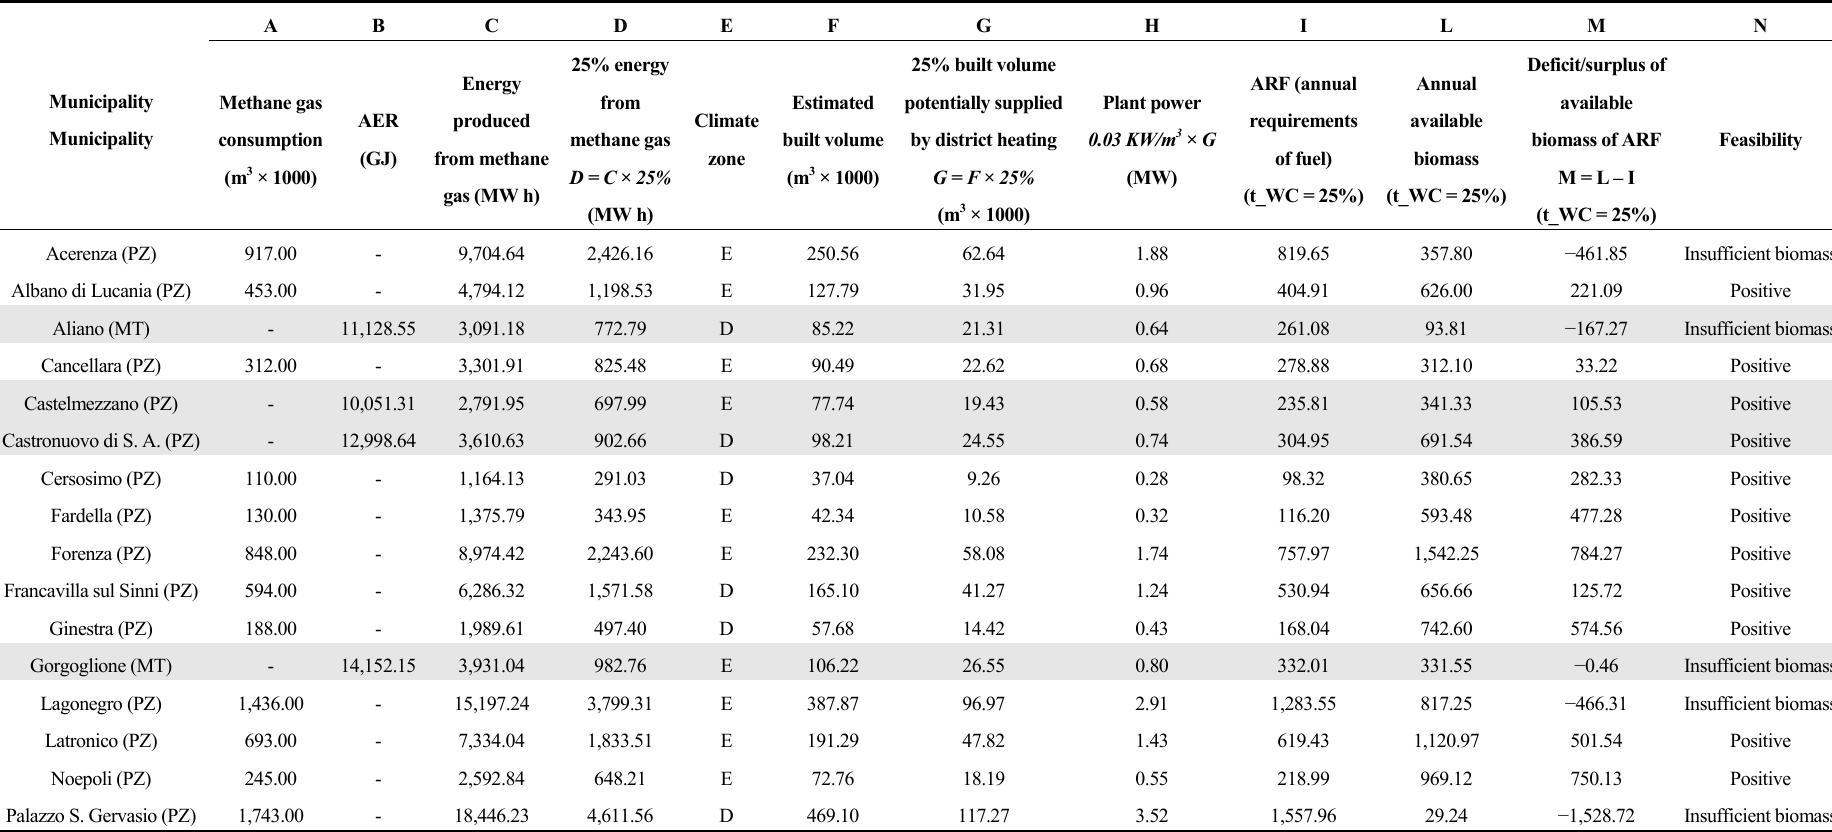
Table 7. Availability and evaluation of forest biomass energy (in gray the municipalities for which the AER was calculated, because the natural gas consumption data were not available). Source: elaboration of the